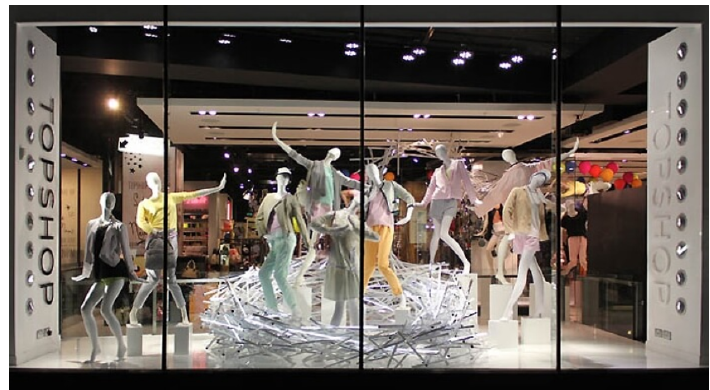
Figure 3. Open display window